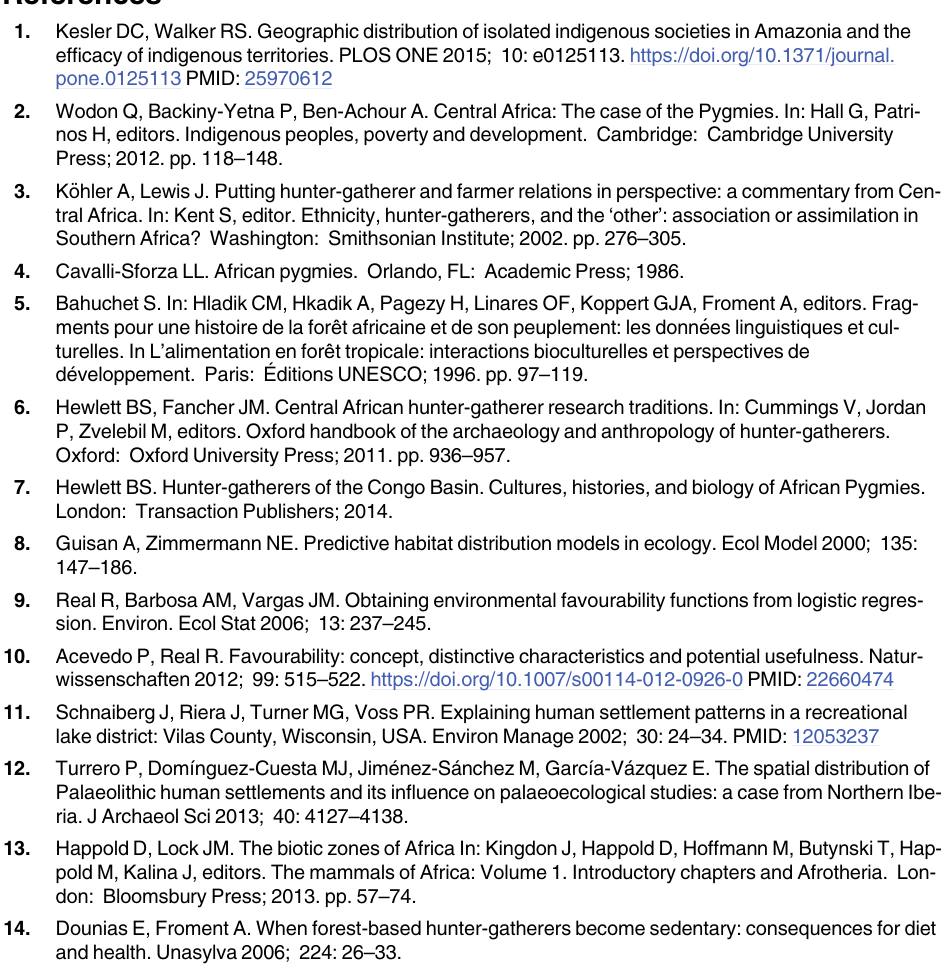
S3 Table. Predictor-variable sources of the 34 predictor variables considered to build the environmental favourability model for